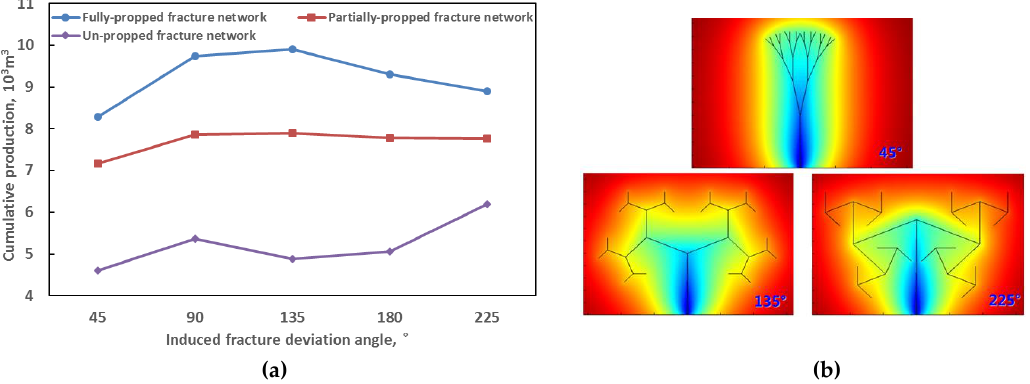
Figure 11. Cumulative production comparison among fractal bifurcate fracture geometries with respect to different fracture network conductivity. ( a ) reflect the cumulative production changed with induced fracture deviation angle; ( b ) represent the pressure distribution at the end of